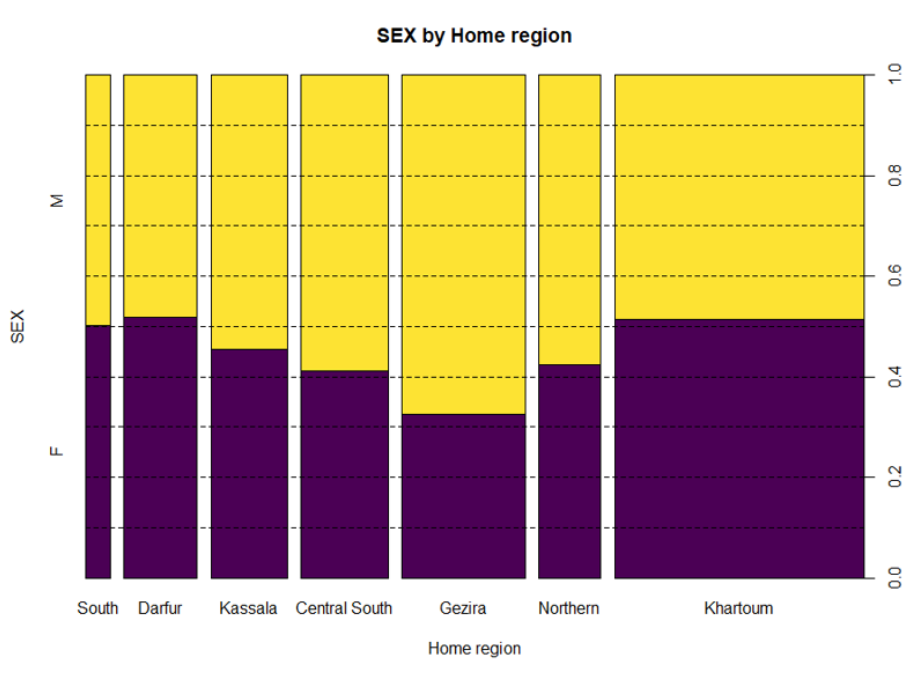
Figure 13. Male/female proportions for incoming diploma students